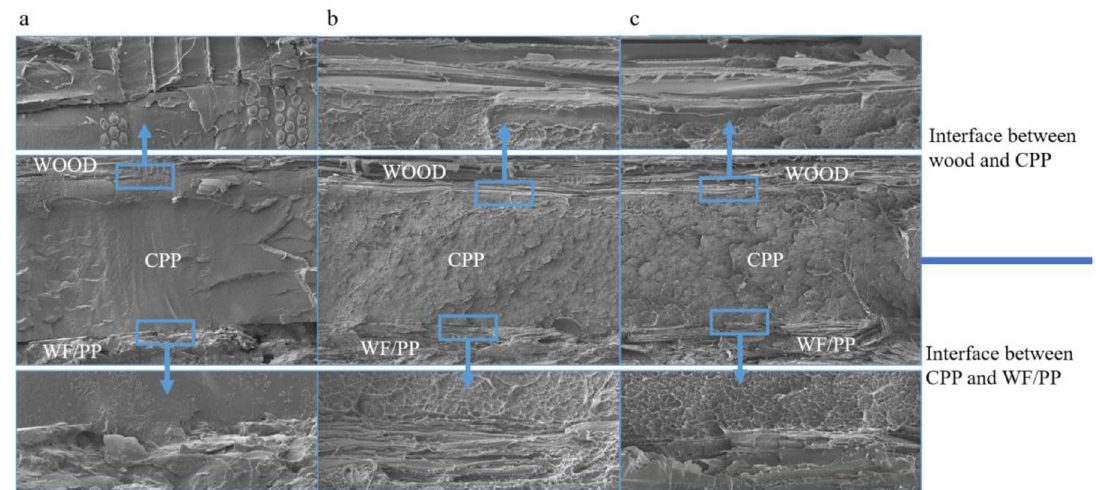
Figure 7. The cross-section SEM images of the interfaces between the wood veneer, CPP, and WF/PP ( a ) WF/ PP = 6/4, ( b ) WF/PP = 7/3, and ( c ) WF/PP = 8/2 composite Surface roughness. The surface roughness is one of factors effecting bonding strength 25,26 . It is found in Fig. 8 that the surface contour height rangeability is raising with the increasing of wood fiber content in WF/ PP composite. Those dents could provide more specific surface area and embedded point for the molten CPP. Parameters of surface roughness are calculated on the basis of ISO 4287:1997 and listed in Table 3. Ra and Rq represent the surface roughness and higher value, respectively, which means the larger roughness. The Rz means the maximum height from the lowest point to the highest. The parameter Ra, Rq and Rz all increase with the increasing of wood fiber content. Combining the statement in surface bonding strength, this surface roughness